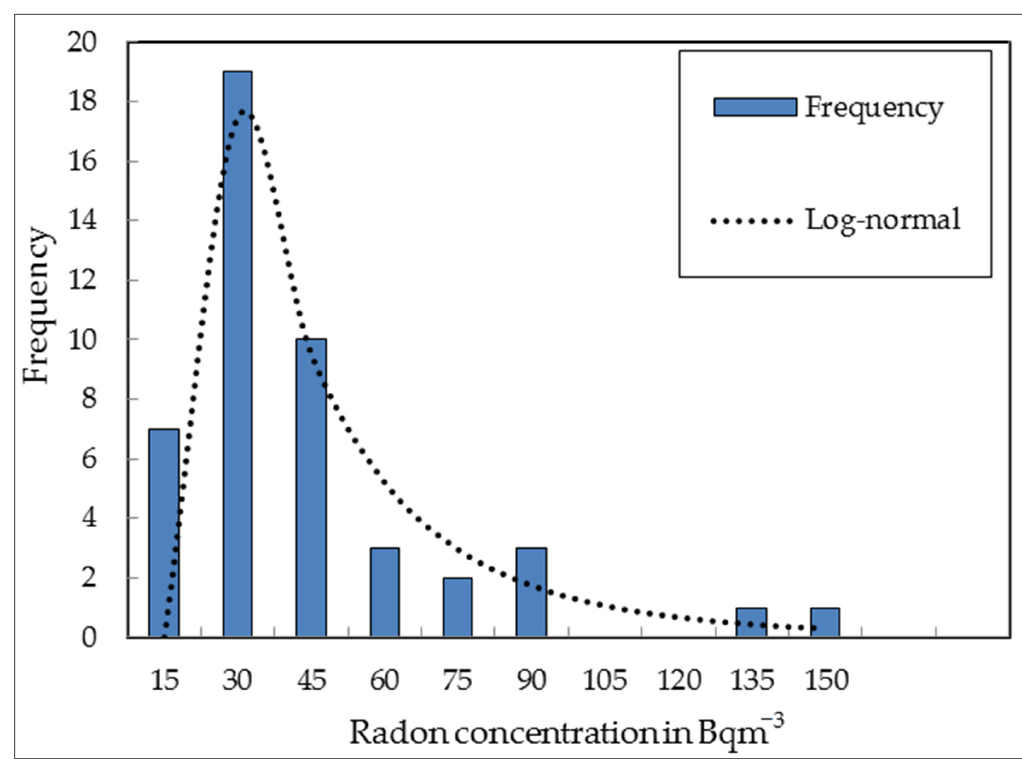
Figure 4. Histogram showing the results of the indoor radon measurements.